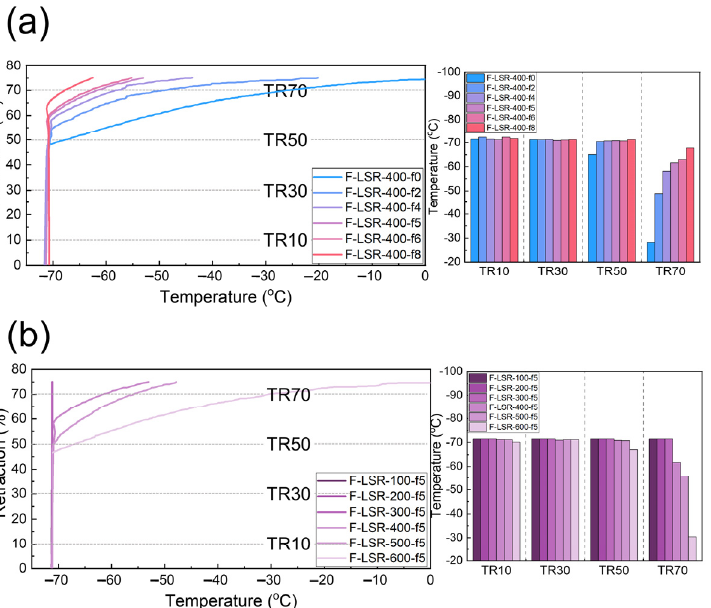
Figure 10. Retraction graphs and analyzing the TR temperature for F-LSRs: ( a ) with different fluorine ratios and ( b ) with different chain lengths.